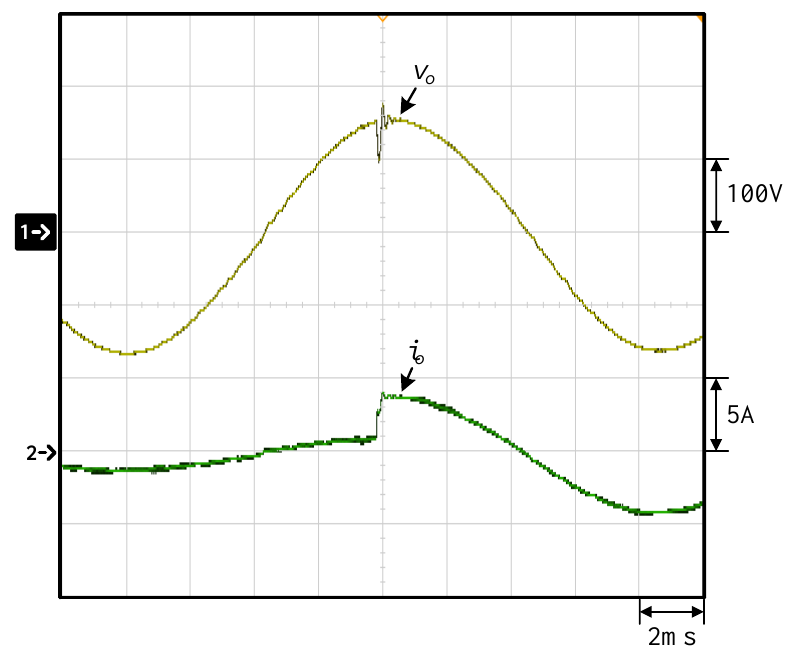
Figure 19. Waveforms measured at rated load with ( a ) (1) v ds 1 , (2) v ds 2 , and (3) v ds 3 ; ( b ) (1) v ds 4 and (2) v ds 5 .